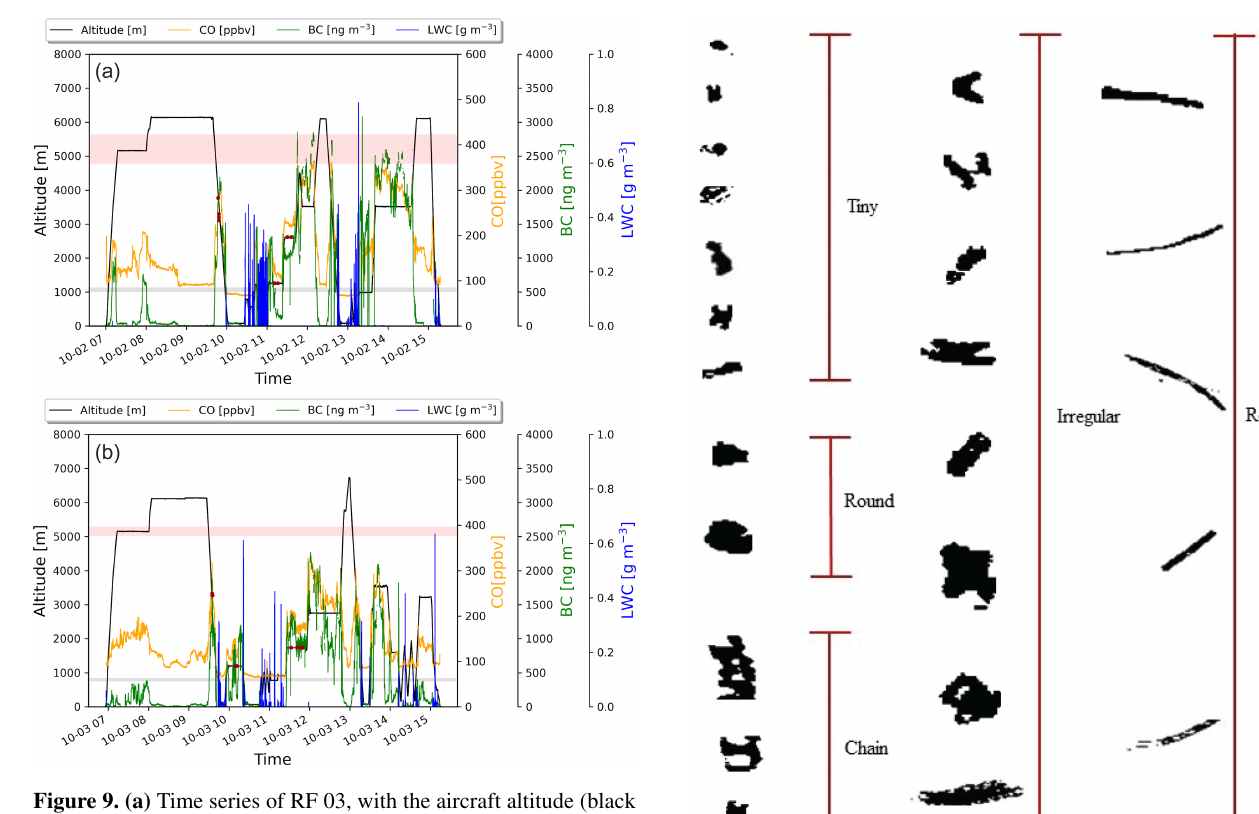
Figure 9. (a) Time series of RF 03, with the aircraft altitude (black line), carbon monoxide (yellow line), black carbon (green line), cloud liquid water content (blue line), height range of top of BB plume (pink bar), height range of top of stratocumulus deck (gray bar), and locations where SAPs were observed red (dots). (b) Same as (a) but for RF 04.